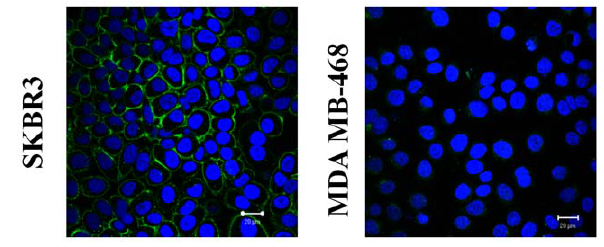
Figure 10. Confocal microscopy of HER2 positive (A) and negative (B) cells exposed to HER2-Affibody-DyLight488. Blue color shows the cell nuclei labeled with Hoechst 33342 and green color shows the HER2-Affibody-DyLight 488.